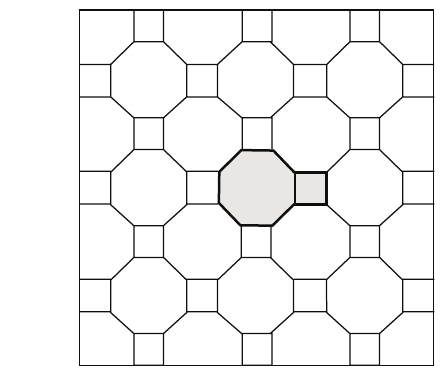
Figure 9: Unit module.